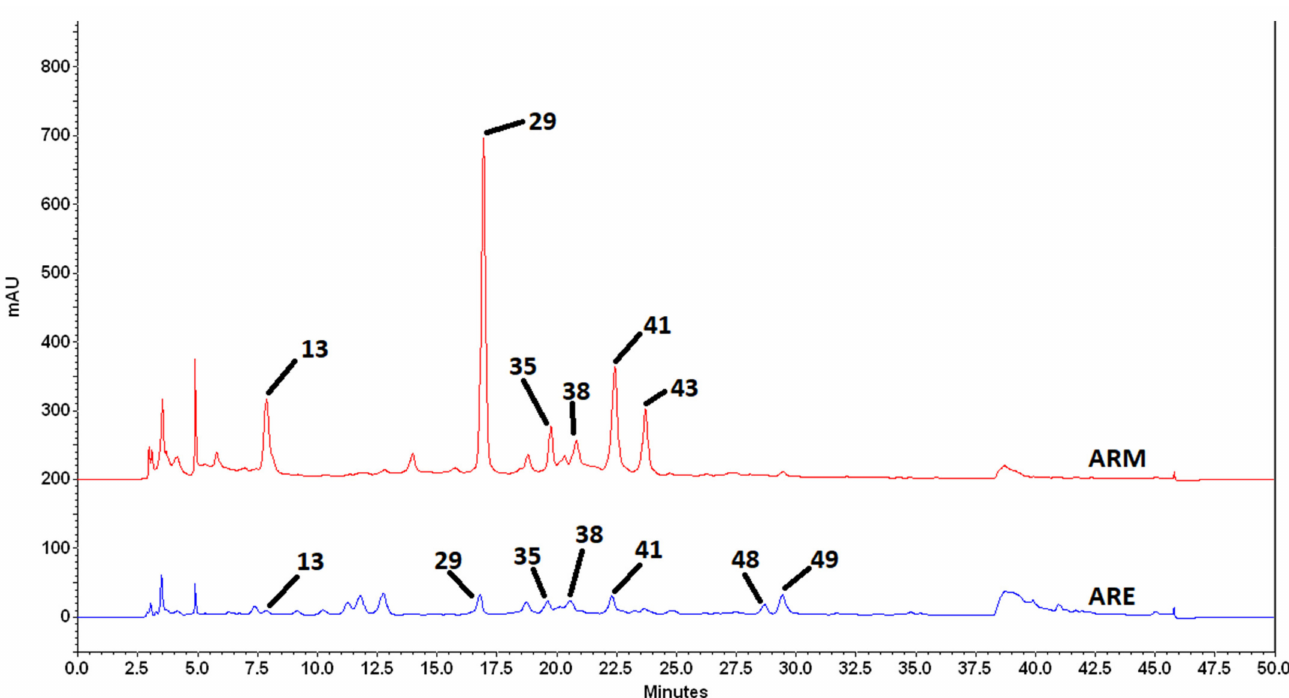
Figure 4. UV chromatogram of ARE and ARM at 254 nm. Chlorogenic acid ( 13 ), rutin ( 29 ),